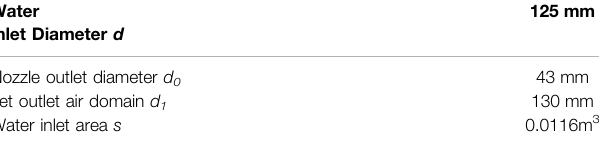
TABLE 1 | Model parameters.